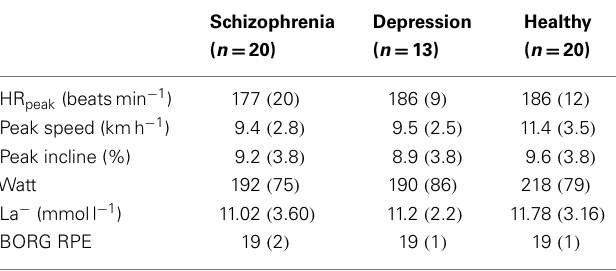
Table 3 | Mean (SD) values of the peak heart rate test